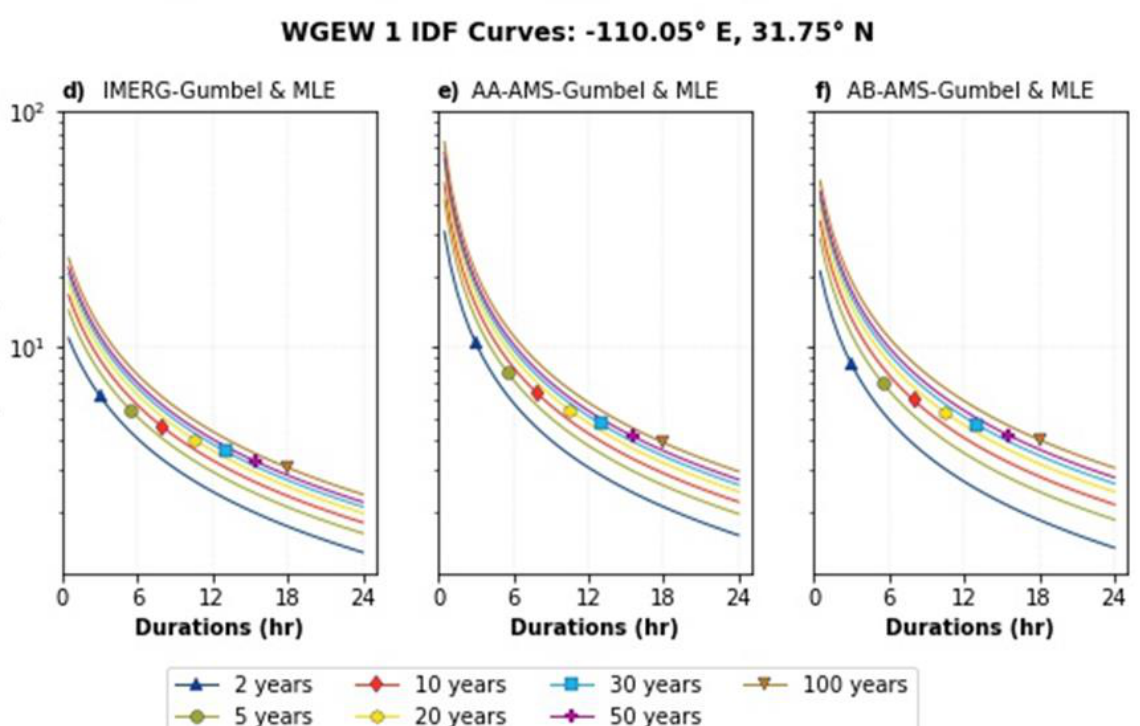
Figure 7. IDF curves fitted with Gumbel and MLE over FBR 2 ( top ) and WGEW 1 ( bottom ) for the 2, 5, 10, 20, 30, 50, and 100 year return periods and durations from half-hour to 24 h. From left to right: IMERG, AA-AMS, and AB-AMS. The marker’s purpose is only to distinguish the IDF curves.